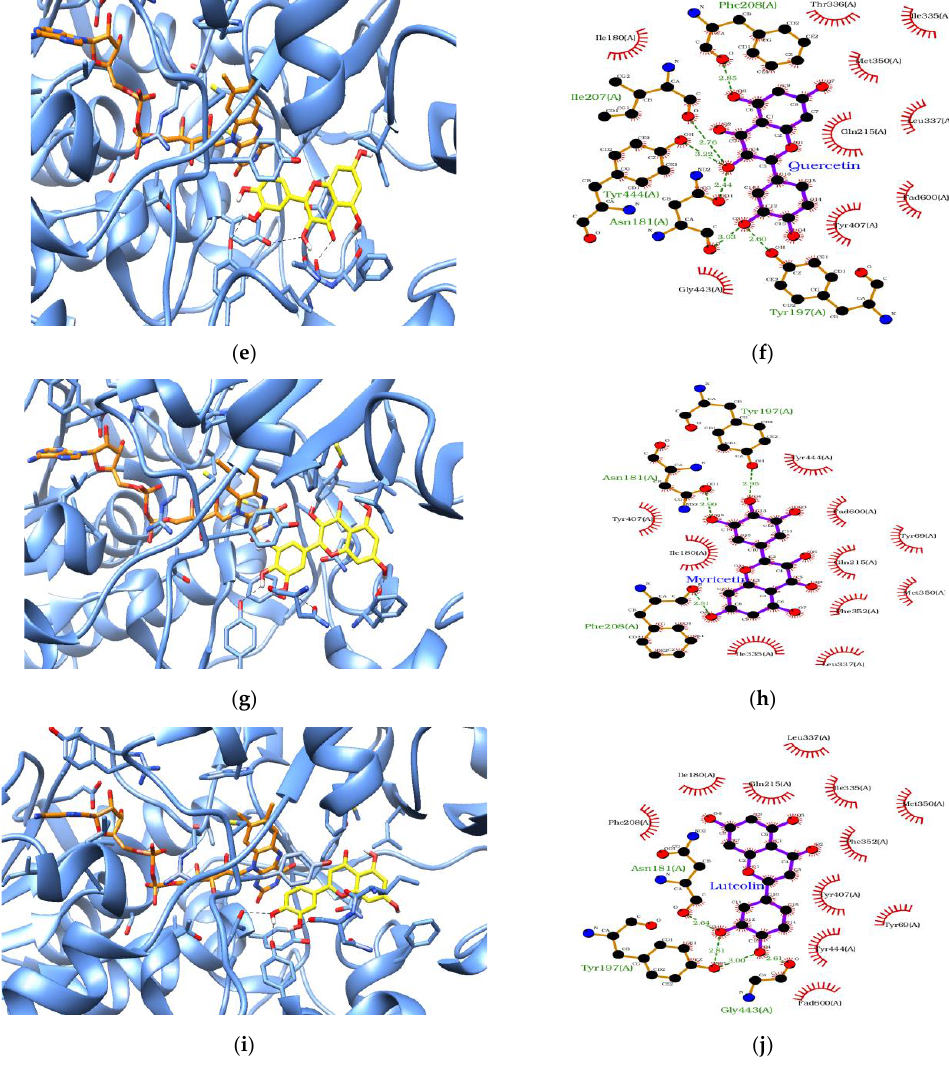
Figure 1. ( a ): MAOA active site with ligand and co-enzyme (protein MAOA is shown in blue, com- pound in yellow and FAD co-enzyme in orange). ( b ) MAOB active site with ligand and co-enzyme (protein MAOB is shown in blue, compound in yellow and FAD co-enzyme in orange). ( c , d ) Inter- action between the first ranked compound (( − )- epicatechin-3-gallate) with the target protein. ( e,f ) Interaction between the second-ranked compound (quercetin) with the target protein. ( g , h ) Interac- tion between the third-ranked compound (myricetin) with the target protein. ( i,j ) Interaction be- tween the fourth-ranked compound (luteolin) with the target protein. (In 3D interaction figures, MAOA and MAOB are shown in blue, compounds in yellow, and FAD co-enzyme in orange).